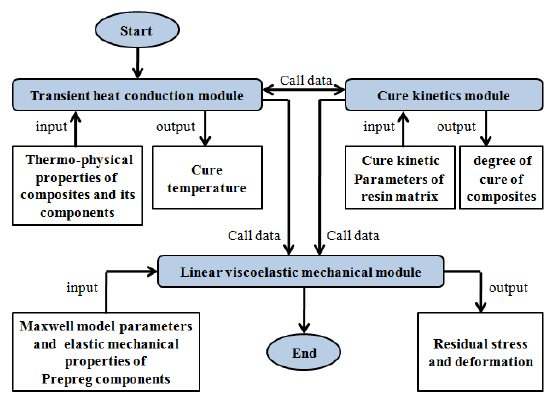
Figure 1. Put forward process to simulate residual stress and deformation under the viscoelastic model. Table 3. Elastic mechanical properties of AS4/3501-6 prepreg constituents [1,2,26].